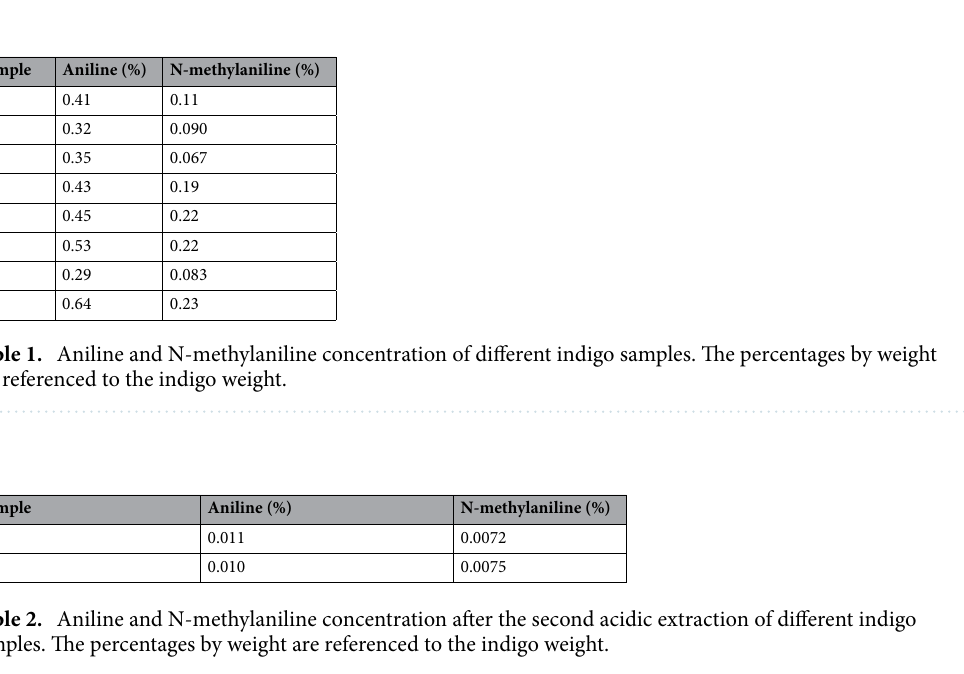
Figure 5. Example for the regression of the linear function of the UV-detector signal versus the standard concentration of the diluted sample solution. The intercept of the regression line with the X-axis determines the sample concentration in the diluted solution.